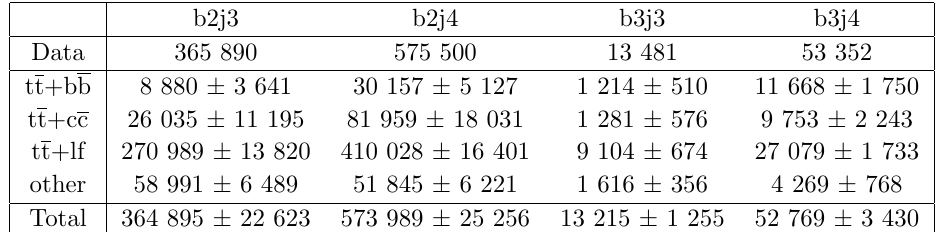
Table 1 . Number of events in each category together with its total relative uncertainty as obtained from the (cid:12)t to data for